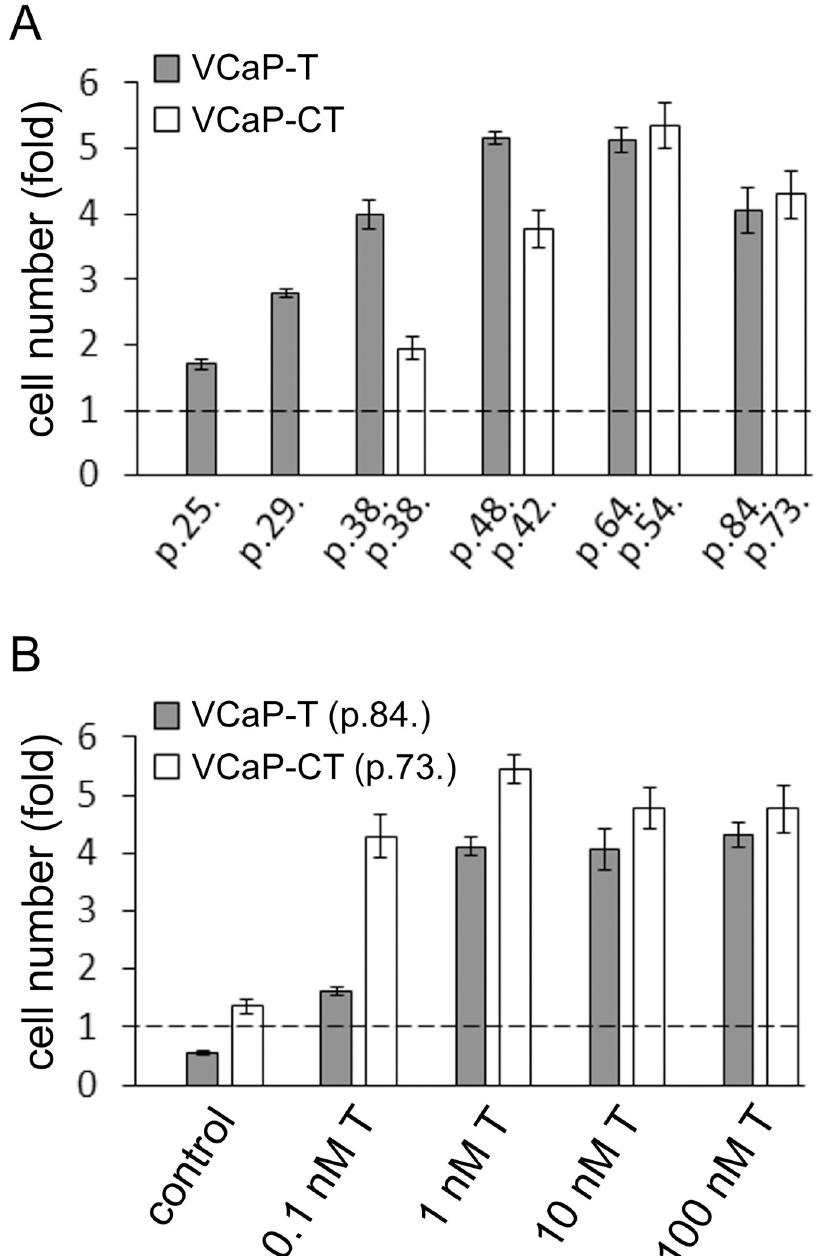
Fig 1. Growth rates of VCaP-T and VCaP-CT during and after establishment. (A) Growth rates of increasing passages (p.) of VCaP-T and VCaP-CT cells during long-term cell culture. (B) Growth rates of VCaP-T (p.84.) and VCaP-CT (p.73.) cells in hormone-depletion (control) and increasing nanomolar (nM) concentrations of T. The cell numbers were measured after 7 days growth and compared relative to the cell number at day 0 (dotted line). Data are represented as mean ± SD and three separate replicates were